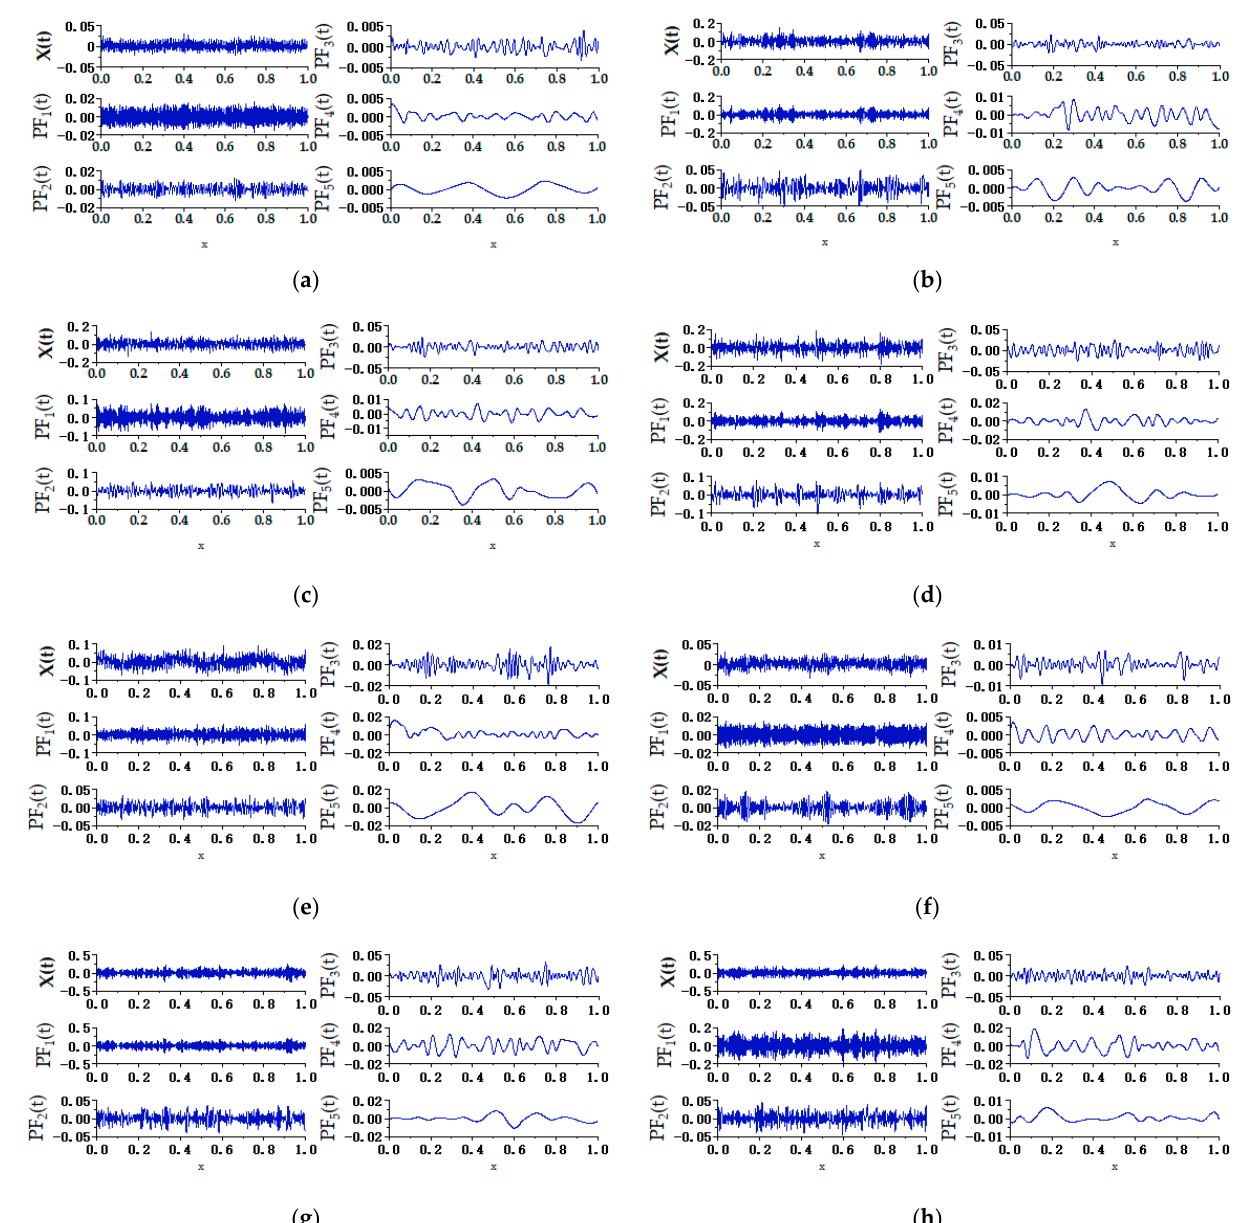
Figure 10. Visualization of local mean decomposition of fault signals. ( a ) normal; ( b ) 2 turns short circuit; ( c ) 4 turns short circuit; ( d ) 8 turns short circuit; ( e ) air gap eccentricity; ( f ) broken rotor strip; ( g ) bearing seat damage; ( h ) bearing wear.